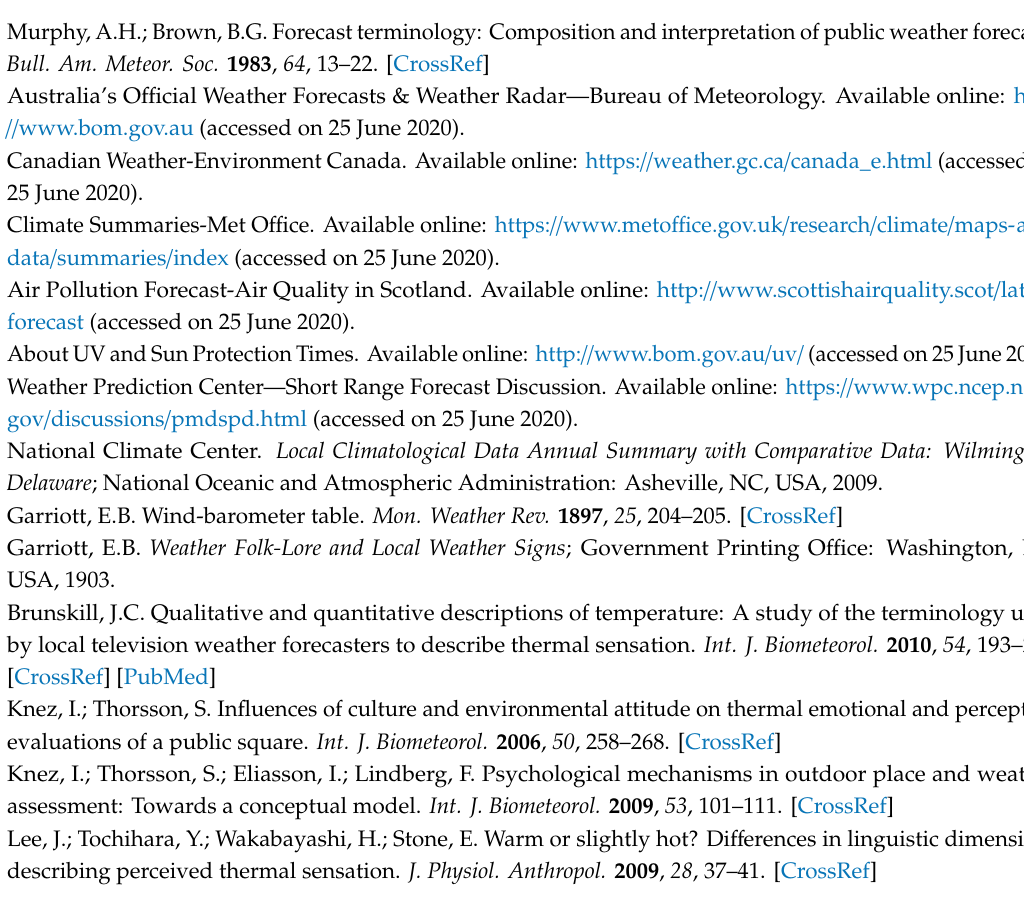
Table S1: Weather Words Descriptive Data (excel file format); Table S2: Sample Item and Response Format (manikins used with permission,